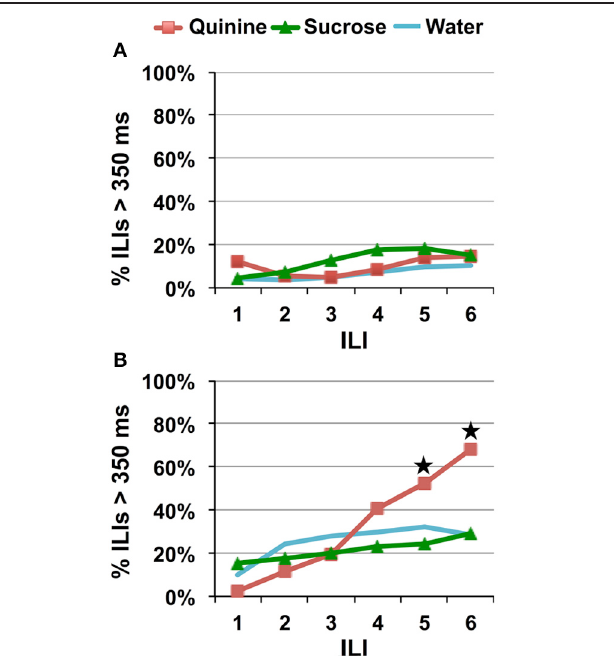
FIGURE 7 | Speed of quinine identification when only sucrose and quinine were presented. Percentage of ILI’s above 350ms. Each stimulus was presented for a single lick. All rats were untrained. (A) Quinine was presented at 0.1mM. (B) Quinine was presented at 10mM. Stars indicate significant difference at p < 0 .